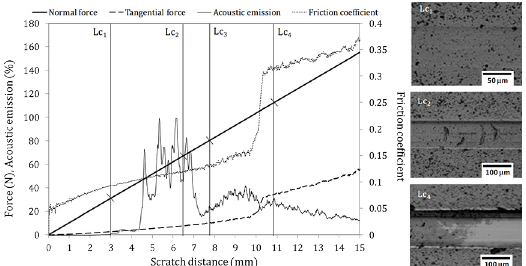
Figure 9. Scratch test results of the duplex-treated